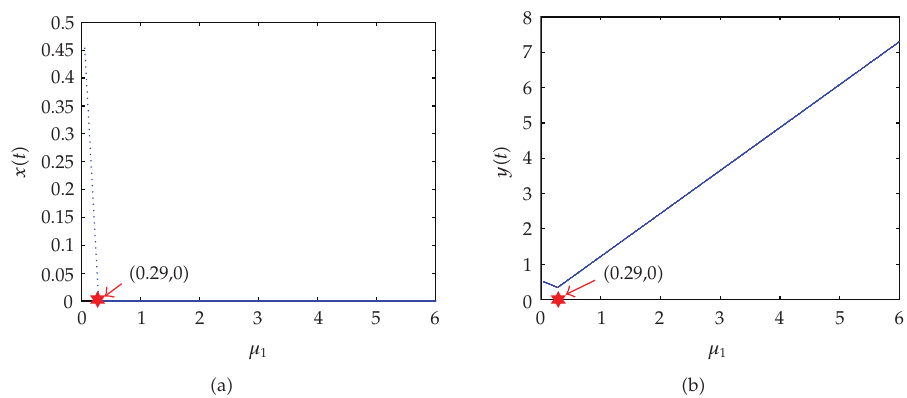
Figure 6: Bifurcation diagrams of system (cid:6) 2.1 (cid:7) , showing the e ff ect of μ 1 with a (cid:8) 0 . 8, b 1 (cid:8) 0 . 9, τ (cid:8) 0 . 7, f (cid:8) 0 . 2, β (cid:8) 0 . 9, η (cid:8) 1, r (cid:8) 0 . 7, b 2 (cid:8) 0 . 3, λ (cid:8) 0 . 9, k (cid:8) 1, g (cid:8) 0 . 5, m (cid:8) 0 . 7, h (cid:8) 2, l (cid:8) 0 . 1, T (cid:8) 2, and μ 2 (cid:8) 0 . 1, initial values x j (cid:6) 0 (cid:7) (cid:8) 0 . 2, x (cid:6) 0 (cid:7) (cid:8) 0 . 1, y (cid:6) 0 (cid:7) (cid:8) 0 . 1, c o (cid:6) t (cid:7) (cid:8) 0 . 01, and c e (cid:6) t (cid:7) (cid:8) 0 . 01. (cid:6) a (cid:7) x (cid:6) t (cid:7) is plotted for μ 1 over (cid:4) 0 . 05 , 6 (cid:5) . (cid:6) b (cid:7) y (cid:6) t (cid:7) is plotted for μ (cid:4) 0 . 05 , 6 (cid:5) 1 over